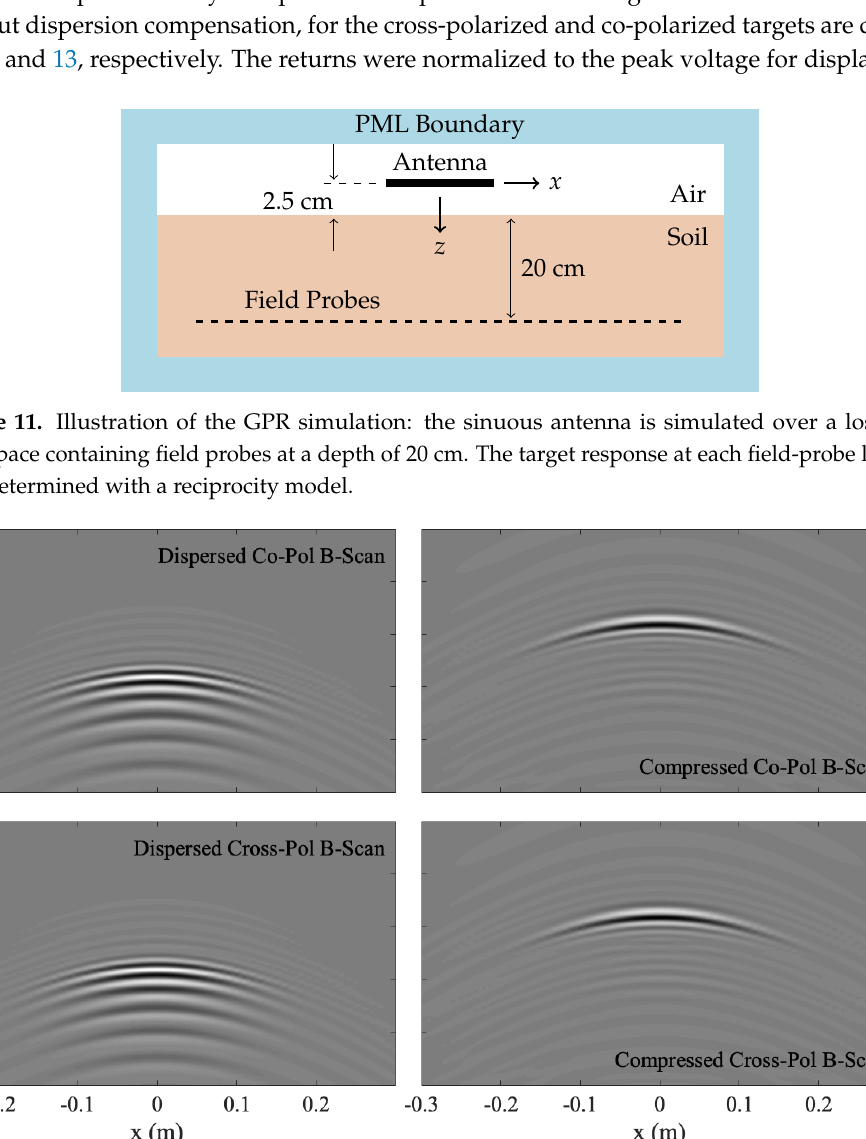
Figure 12. GPR simulation results: dispersed co-pol and cross-pol B-scans ( left ) and corrected B-scans using an optimized dispersion model ( right ) for a small linear target aligned at a 45 ◦ angle to the incident wave